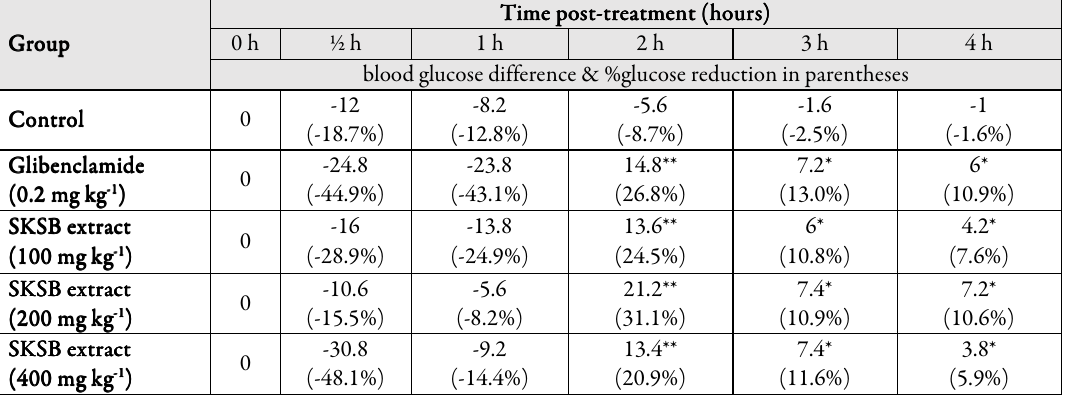
Table 1b. Calculated blood glucose difference & Percentage reduction post-treatment of normal rats Group